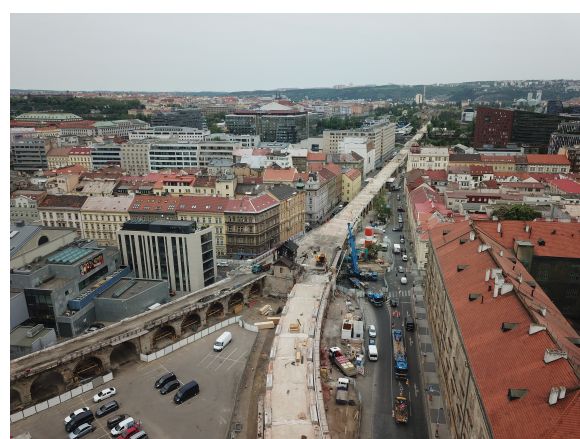
Figure 1. Bird’s-eye view of the Negrelli’s Viaduct during the